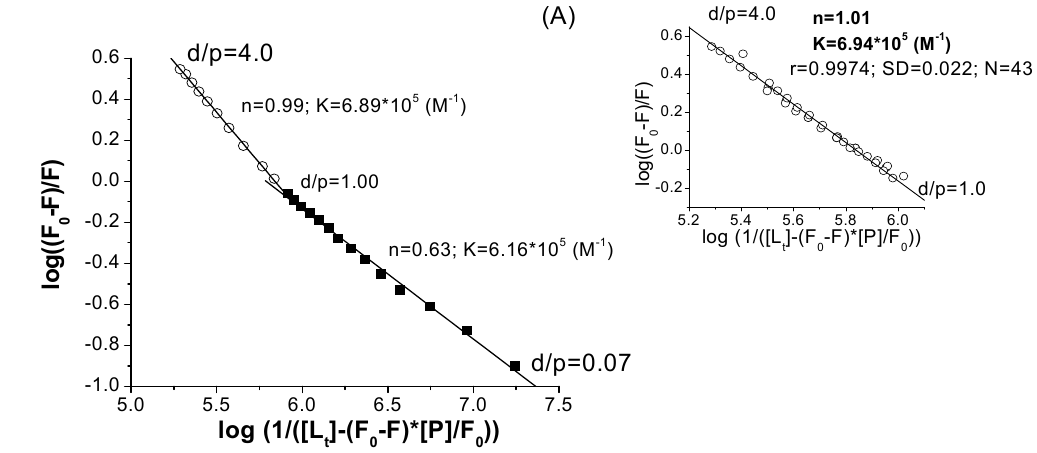
Figure 5. (A) Two linear segments fitting plot for the HSA– I system to Equation (6); = 286 nm; λ = 345 nm; inset, a triplicate experiments for [HSA] = 3 × 10 -6 M; λ ex em d/p ≥ 1.0, fitted to Equation (6). (B) Two linear segments fitting plot for the = 286 nm; λ = 346 BSA– I system to Equation (6); [BSA] = 3 × 10 -6 M; λ ex em